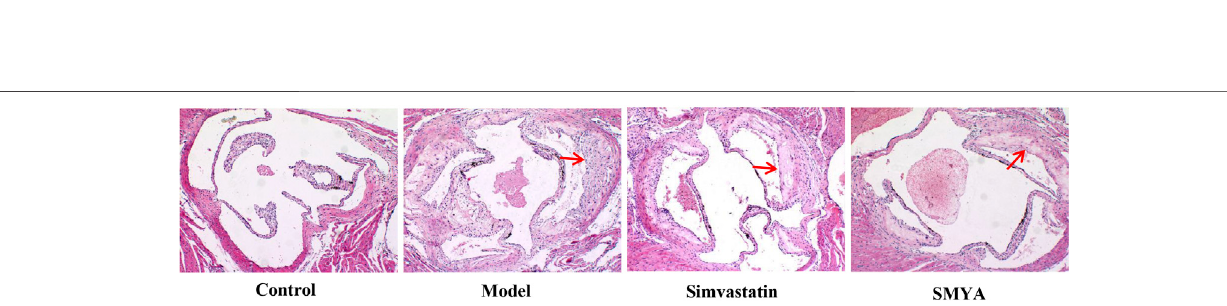
Frontiers in Pharmacology |